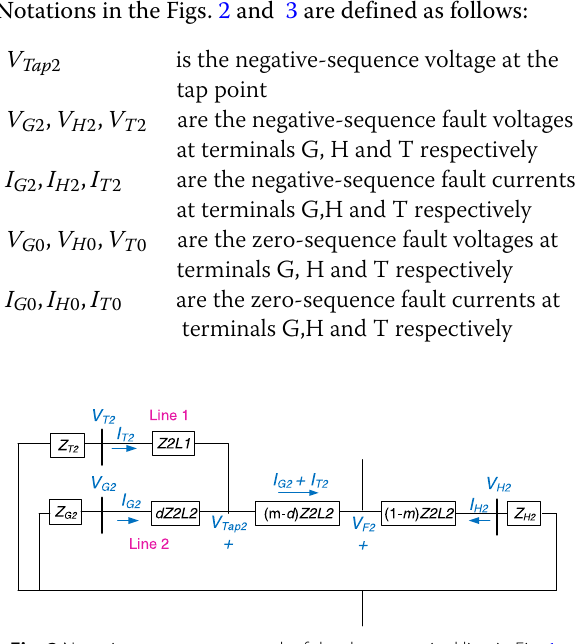
Fig. 2 Negative-sequence network of the three-terminal line in Fig. 1 during a single or double line-to-ground fault